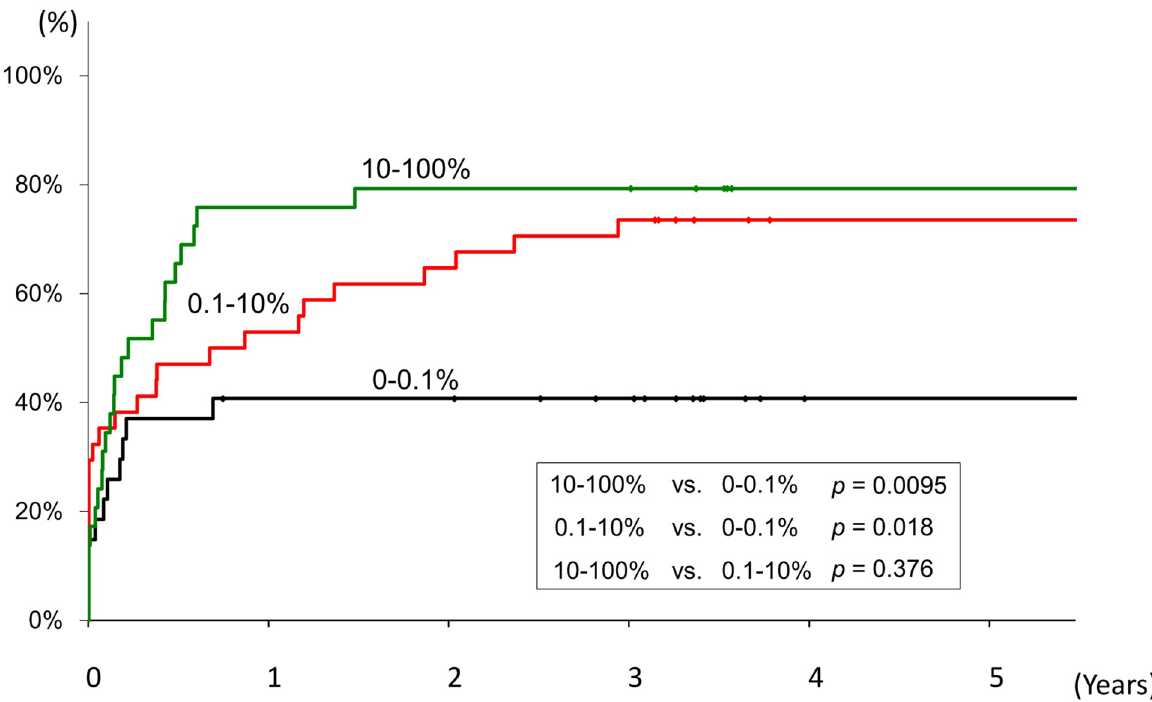
Fig 6. Frequency of the preS codon 132–141 deletions and its influence on the requirement for future nucleoside analogue therapy. Kaplan- Meier curves were drawn according to the frequency of the preS codon 132–141 deletions to determine the influence of the deletions on the requirement for future nucleoside analogue therapy over the ensuing five years. As is shown, compared to the patients with the preS codon 132– 141 deletions 0–0.1%, NA therapy was introduced more often in patients with high deletion frequencies (10–100%, p = 0.0095) or with intermediate deletion frequencies (1–10%, p =